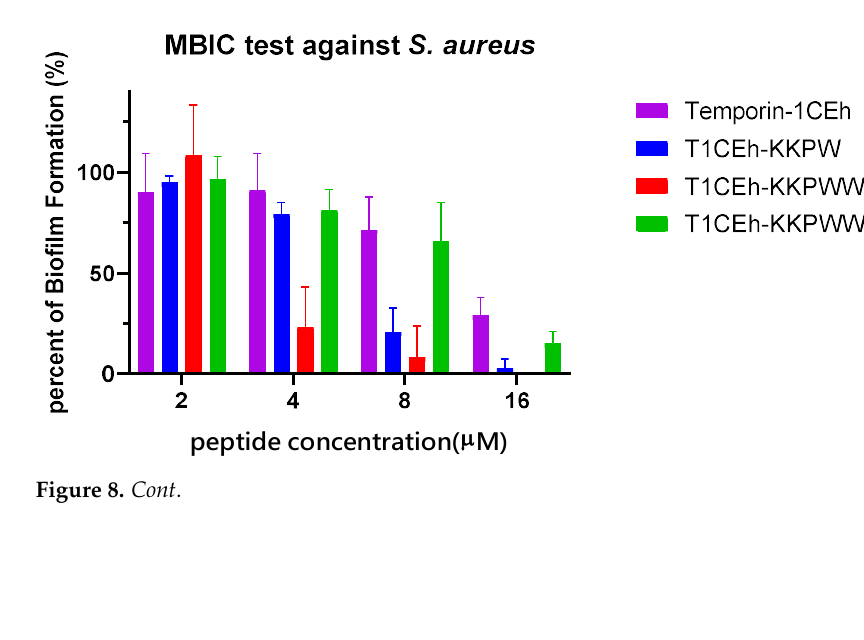
Figure 7. The permeability proportions of Temporin-1CEh, T1CEh-KKPW, T1CEh-KKPWW and T1CEh-KKPWW2 in increasing concentrations on S. aureus (ATCC CRM 6538) and E. coli (ATCC 8739). The positive and negative controls used 70% isopropanol and 5% tryptic soy Broth (TSB) for S. aureus or Lysogeny broth (LB) for E. coli in 0.85% NaCl, respectively. Error bars represent the standard error of the mean (SEM) of three